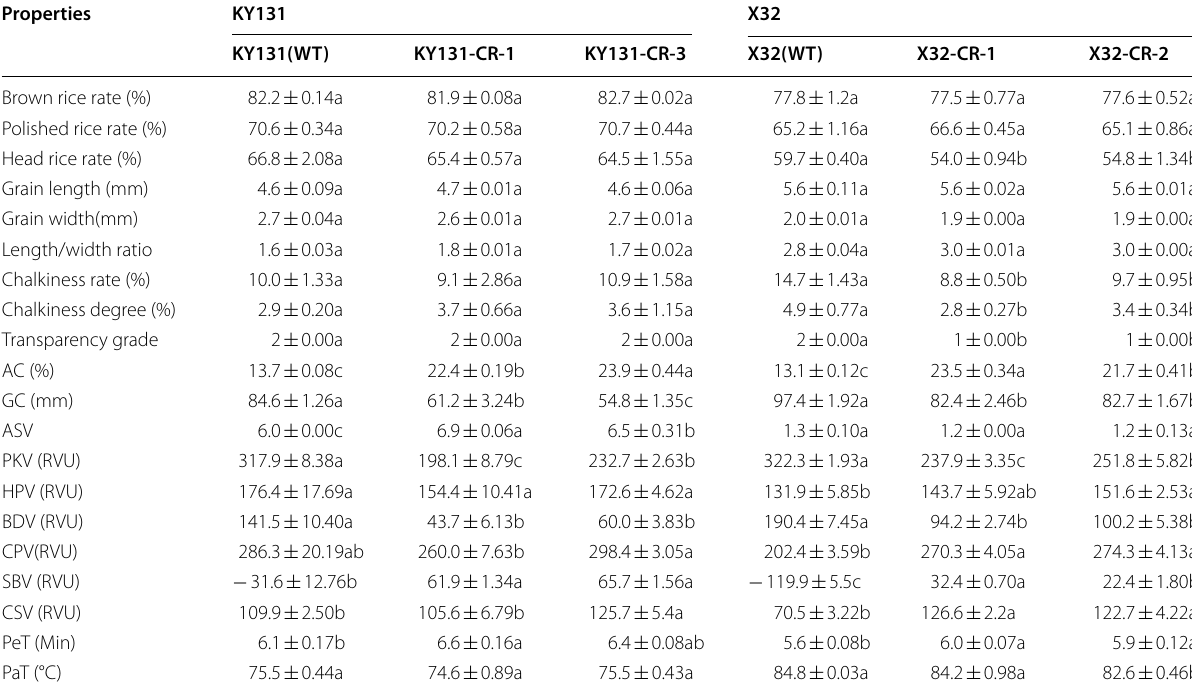
Values reported are mean SEM. Different letters following the mean values stands indicate significant differences ( P < 0.05). AC, amylose content, GC, gel consistency, ± ASV, alkali spreading value; PV, peak viscosity; HPV, through viscosity or hot paste viscosity; CPV, final viscosity or cool paste viscosity; BDV, breakdown